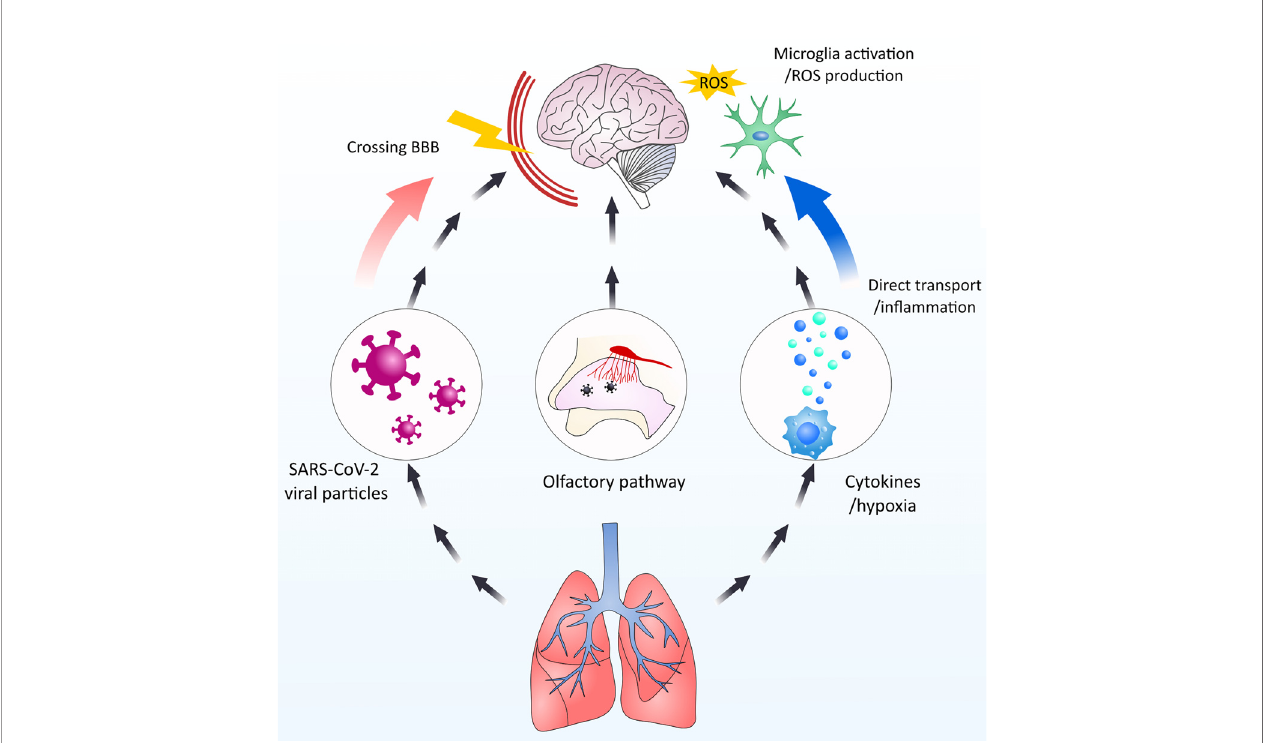
FIGURE 4 | Schematic overview of the possible interactions of SARS-CoV-2 and CNS. SARS-CoV-2 particles could potentially and negatively in fl uence the CNS by multiple means. 1. Directly entering the CNS via crossing the BBB. 2. By-passing the BBB by entering via the olfactory nerve. 3. Indirect in fl uence via microglia activation by cytokines in fi ltration from the periphery and hypoxia-induced